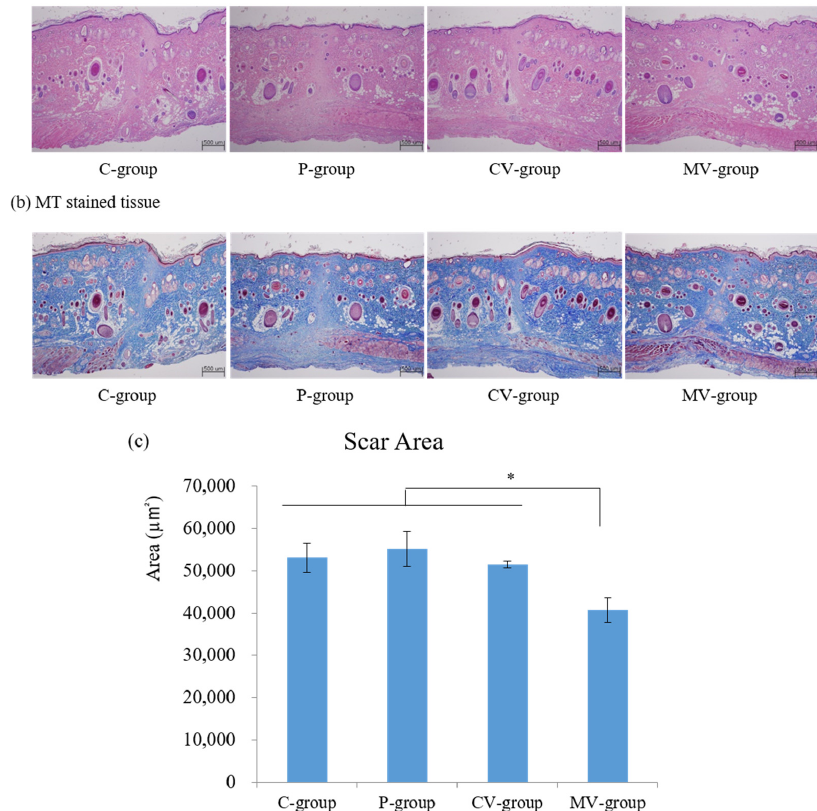
Figure 5. H&E and MT-stained tissues from the C-, P-, CV-, and MV-groups in rat incisional scar model on day 14 (40 × ). ( a ) H&E and ( b ) MT-stained tissues from the C-, P-, CV-, and MV-groups on day 14 (magnification, 40 × ). The C-group continued to present a wide area of granulated tissue with inflammation. The MV-group presented lower levels of immature collagen deposition within scar areas; ( c ) The scar area was significantly narrower in the MV-group than in the C-, P-, and CV-groups on day 14. (* p < 0.05). C-group, control group-PBS injection; P-group, PPA injection; CV-group, control virus with PPA complex injection; MV-group, shMot virus with PPA complex injection. Data are expressed as mean ± SD ( n = 5). * p < 0.05 indicates statistically significant differences as compared with the control